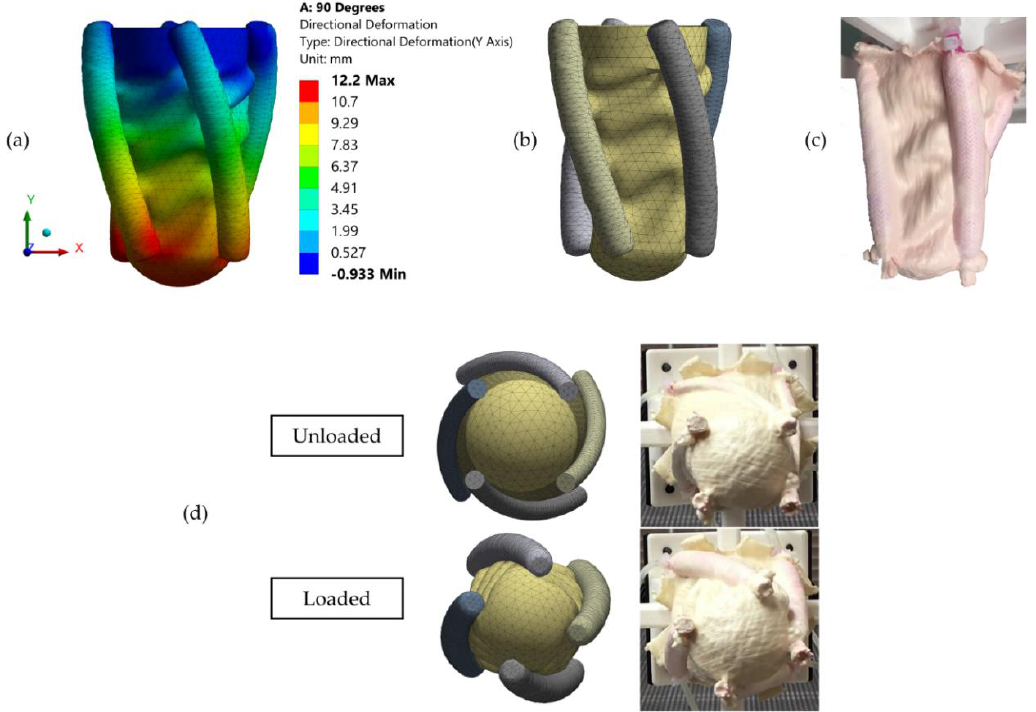
Figure 7. ( a ) Contour bands of the directional deformation along the y-axis. The positive y-axis is located on the upward direction; ( b ) Deformed FE model; ( c ) Deformed LV simulator prototype; ( d ) Before and after loading states of the model and the experiment from the apical view. Similar deformation mechanics were observed on the model and the experiment.